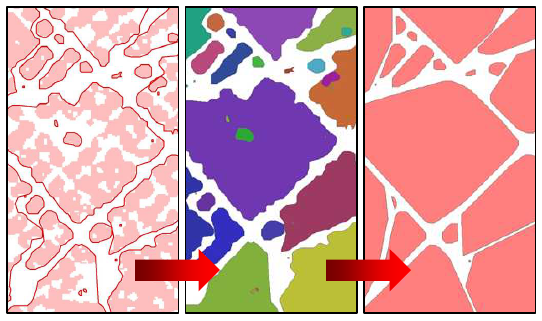
Figure 6: (Left) combined image using image segments. Figure 7: (Middle) extracted spatial units based on morphological analysis, a raster presentation of clustered blocks.